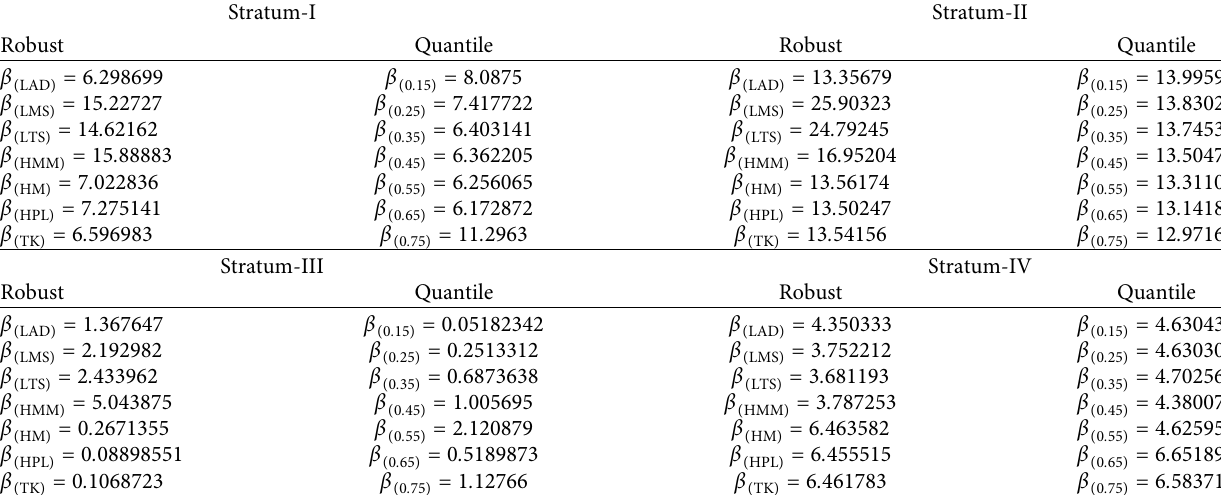
Table 2: Population-1 regression